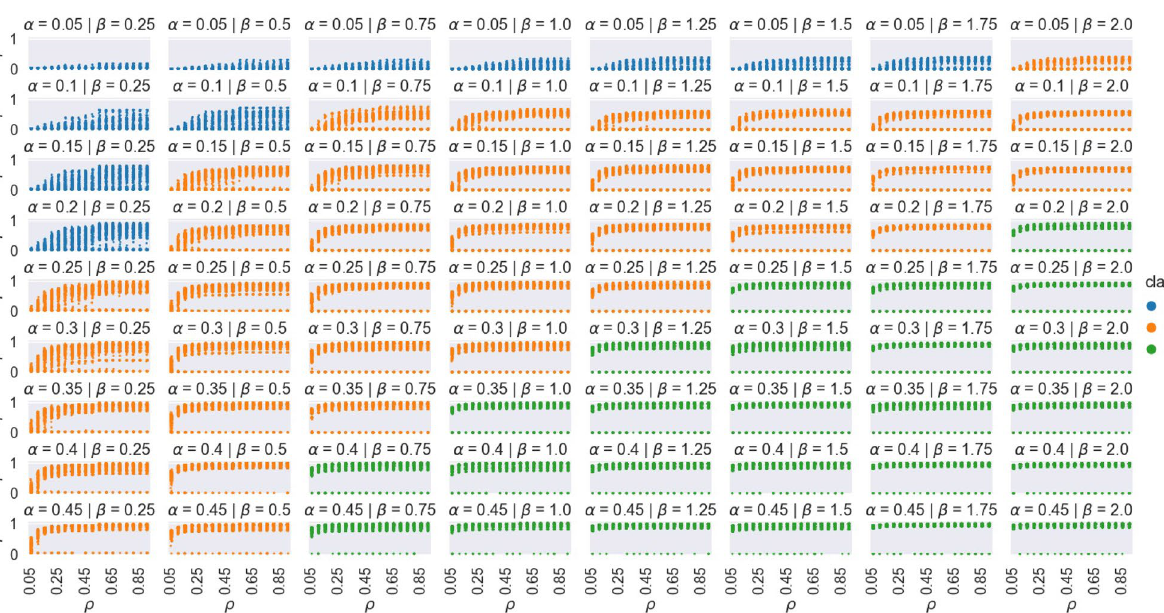
Figure 8. The effect of ρ on φ under different α and β . Three classes of behavior can be